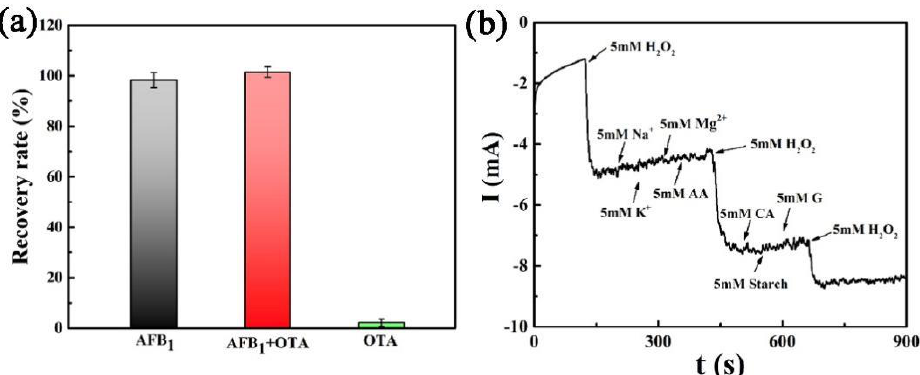
Figure 6. ( a ) Recovery rates of the developed biosensors for the detection of AFB 1 and the mixture of AFB 1 and OTA. Error bars were obtained from three independent measurements. ( b ) Selectivity test of the biosensor toward H 2 O 2 by interference with Na + , K + , Mg 2+ , AA, CA, starch and G.